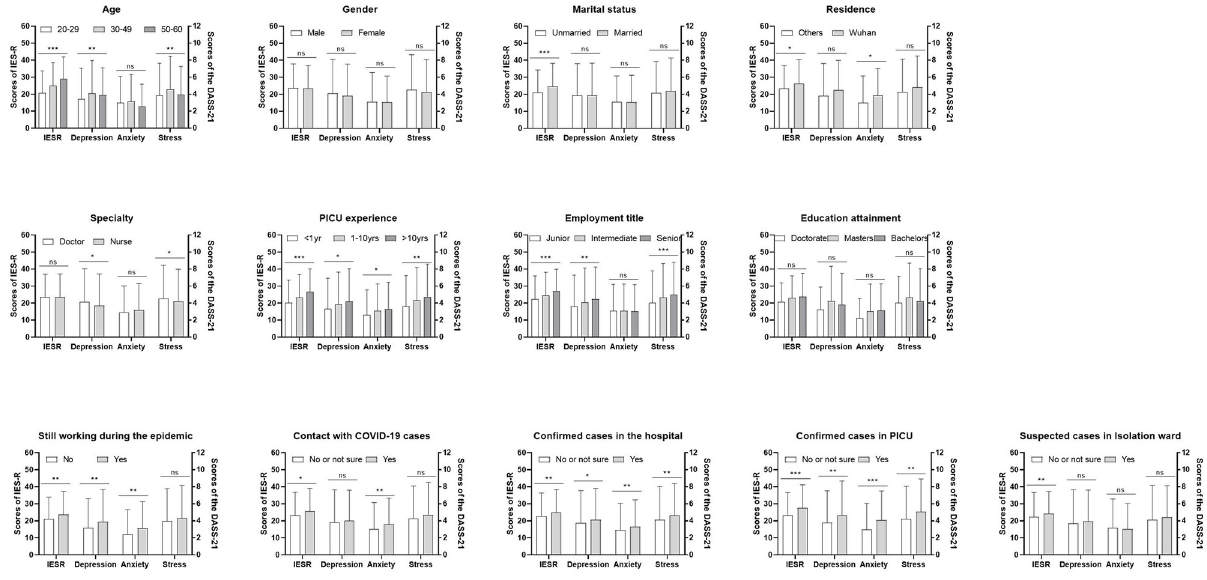
Fig 1. Relationship between baseline characteristics and psychological